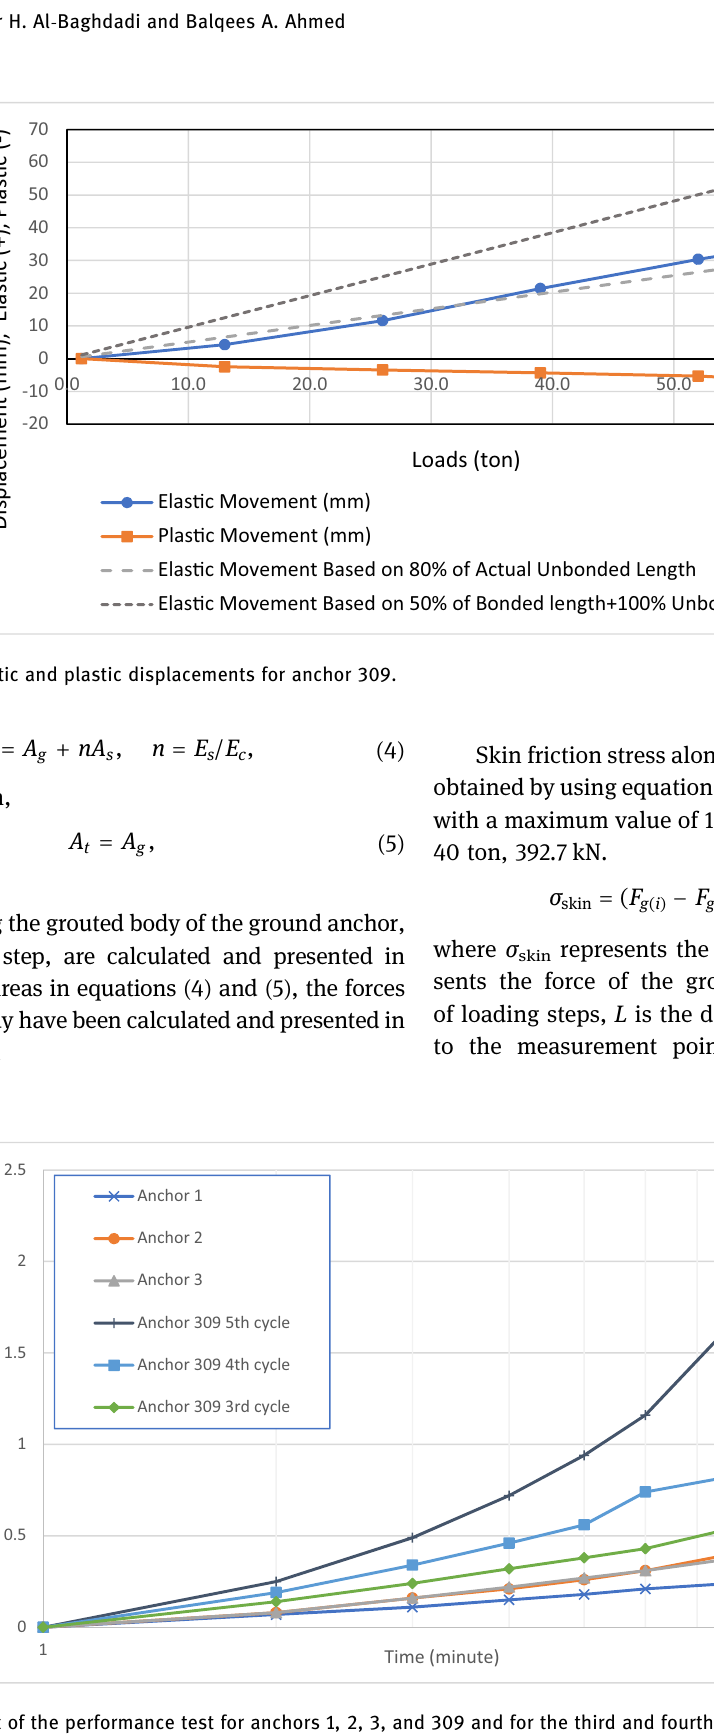
Figure 16: Creep part of the performance test for anchors 1, 2, 3, and 309 and for the third and fourth loading cycles.